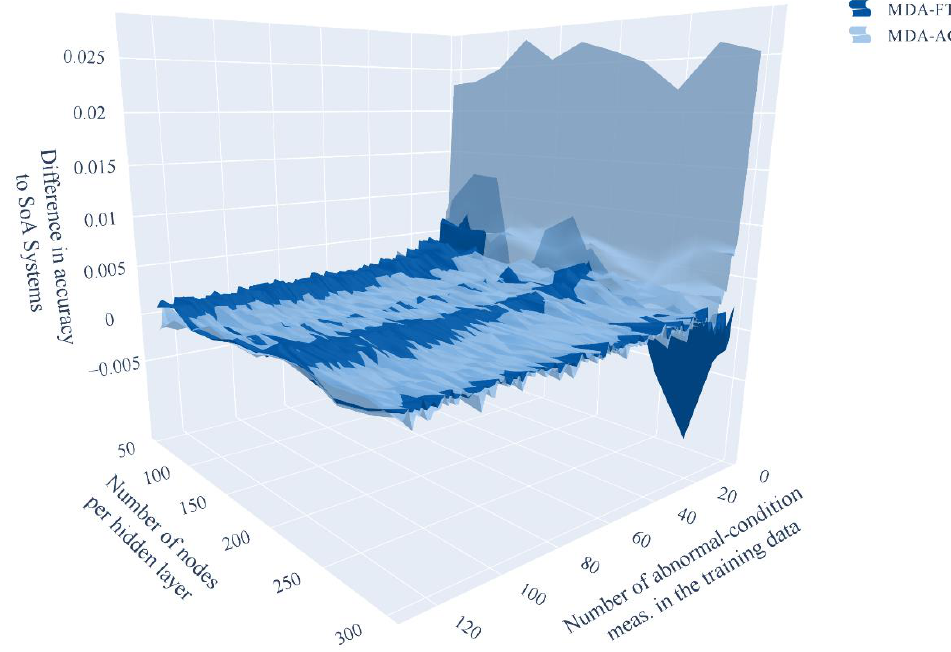
Figure 18. Differences in accuracy between the MDA-FT , MDA-AC , and the SoA Systems . Table 3. Averaged difference in accuracy between the MDA-FT , MDA-AC , and the SoA Systems . Averaged Accuracy Difference in %